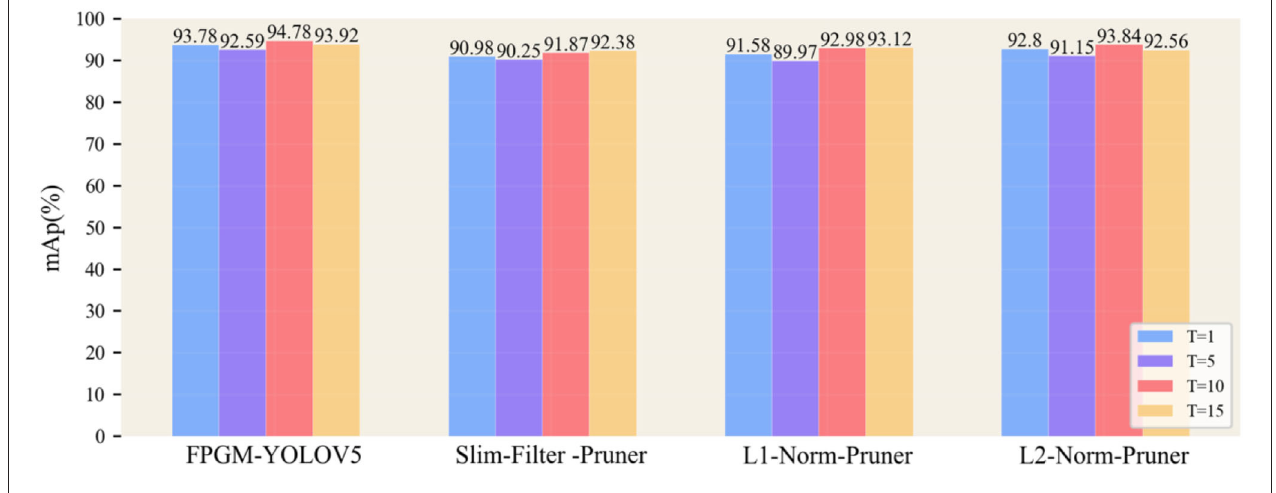
FIGURE 12 | Effect of temperature parameters on knowledge distillation.